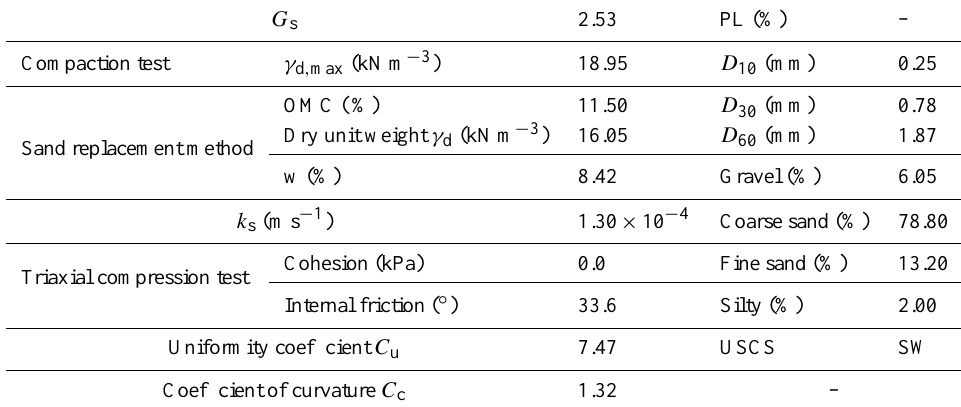
Table 1. Physical properties of